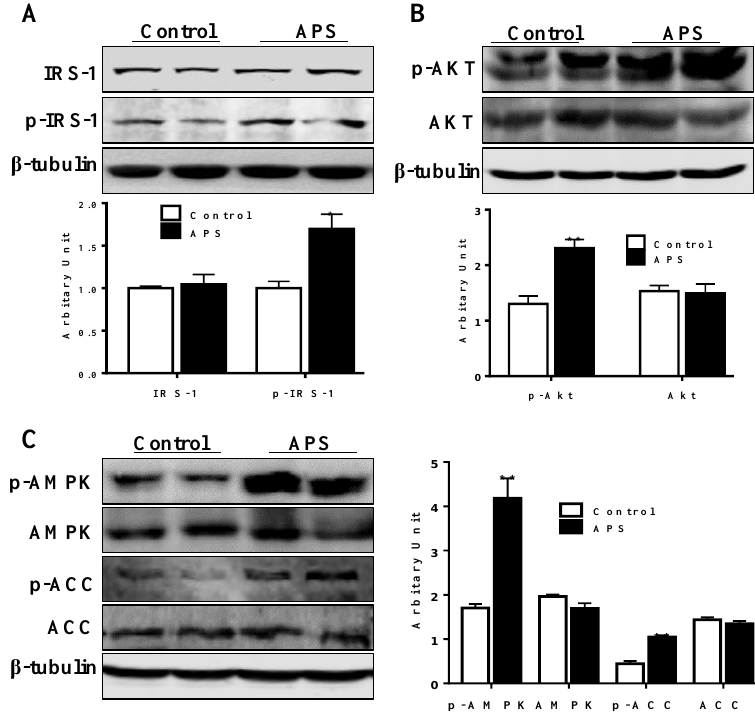
Figure 4. Effect of APS treatment on insulin receptor substrate protein 1 (IRS1), Akt, and AMP-